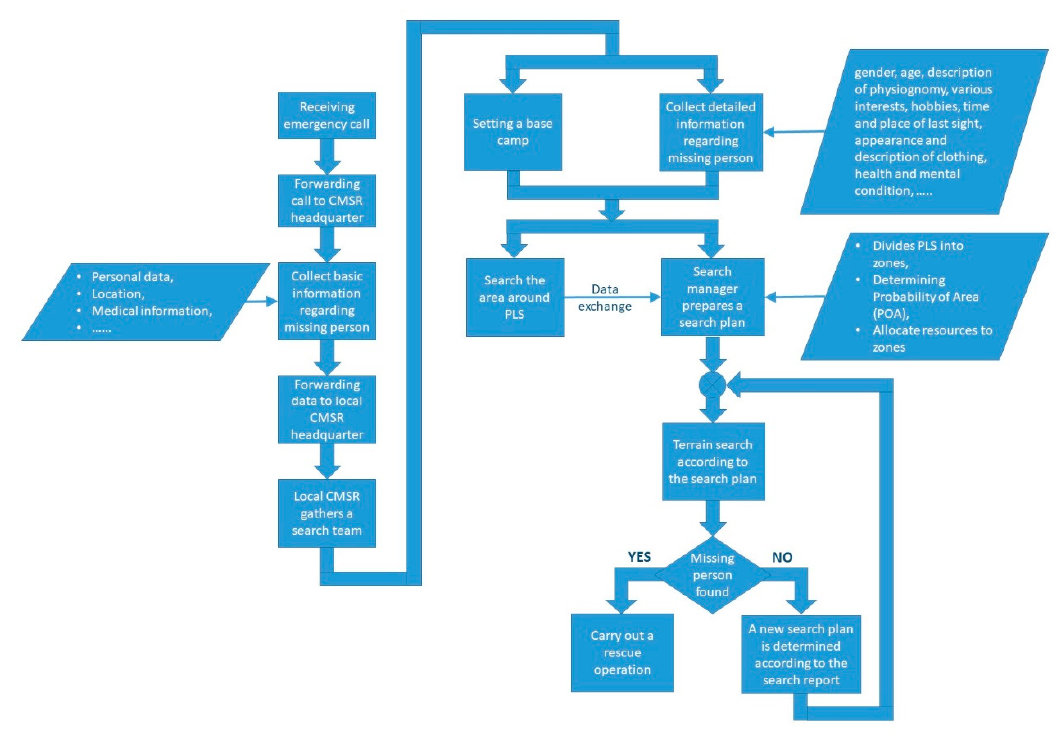
Figure 3. The flowchart of the search-and-rescue (SAR) mission procedure.